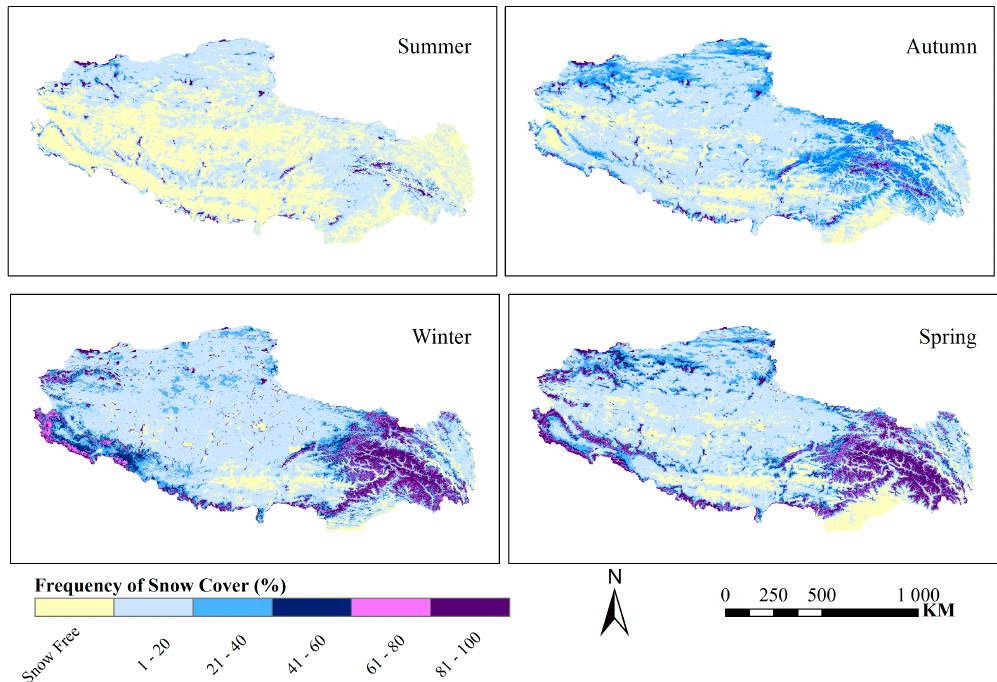
Figure 4. Spatial distributions of snow cover frequency after persistent cloudiness correction for each season. Table 2. Periods and start/end dates for the four different seasons of MODIS 8-day snow cover data.